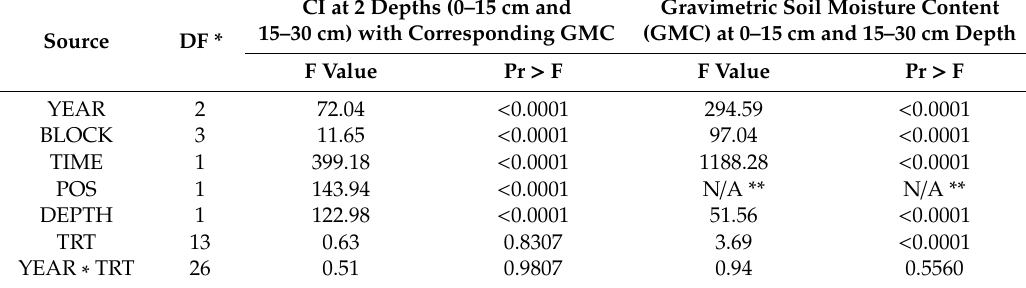
Table 6. Analysis of variance of soil cone index (CI) at the two depths (0–15 cm and 15–30 cm) with the corresponding gravimetric soil moisture content